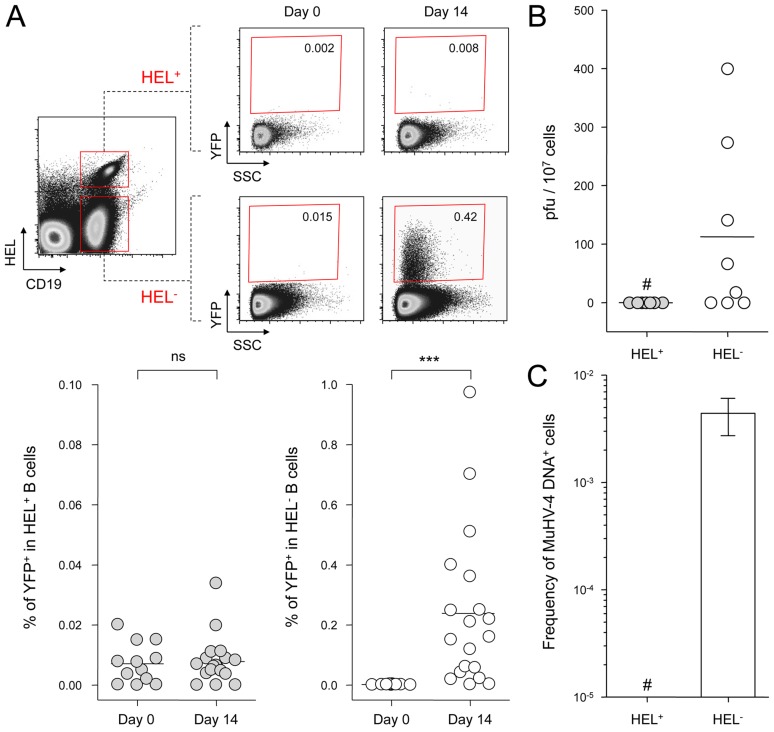
MuHV-4 latent infection is restricted to polyclonal HEL− B cells.SWHEL mice were left untreated or infected for 14 days with YFP-MuHV-4 virus at 104 PFU. Splenocytes were isolated and analyzed by FACS or sorted for plaque assay and limiting dilution PCR analysis. HEL+ and HEL− B cells were identified based on HEL-A647 binding and CD19 expression. (A) On top are representative FACS plots showing the percentage of YFP+ cells in both populations at 0 and 14 dpi. Data are compiled in the graphics below showing percentage of YFP+ cells in HEL+ (grey circles) and HEL− (white circles) B cells at day 0 (n = 12) and 14 (n = 16) dpi. The bar represents the average percentage. (B) To detect presence of latent MuHV-4, a plaque assay was performed on sorted HEL+ and HEL− B cells 14 dpi (n = 8). # indicates that no plaques were detected in HEL+ B cells and based on the average number of HEL+ B cells plated, we estimate the level of latent infection to be <1 PFU/382000 in this population. The analysis of lysed cells showed an absence of preformed viral particles in both populations. (C) Limiting dilution PCR was performed to detect viral genome in sorted HEL+ and HEL− B cells from day 14 infected SWHEL mice. Data are representative of two independent experiments in which splenocytes were pooled before sorting (n = 3 & n = 2). The frequency of cells harboring MuHV-4 DNA is shown, # indicates signal below the assay's limit of detection. We evaluated the frequency of MuHV-4 DNA+ cells in HEL+ B cells to be ≤1/36770 and ≤1/102891 for the two experiments we performed. Error bars indicate the 95% confidence interval. Purity of sorted cells was systematically above 90%.